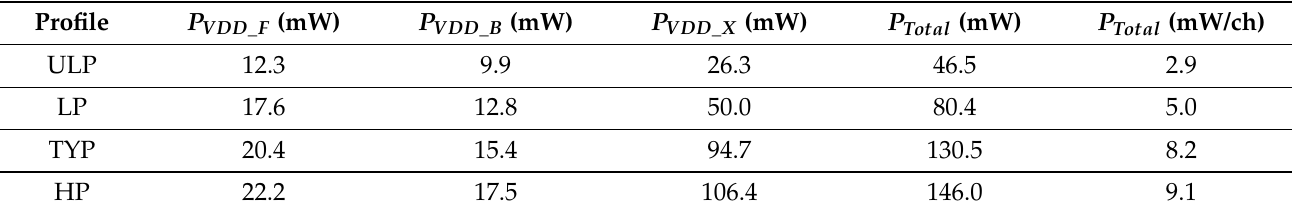
Table 2. Power consumption for each profile. P VDD _ F supplies the Frontend Readout blocks: edge detectors, TCMs, and coarse counters. P VDD _ B supplies the Backend Readout blocks, Serializers, and SPI. P VDD _ X supplies the PLLs and RIMCs.